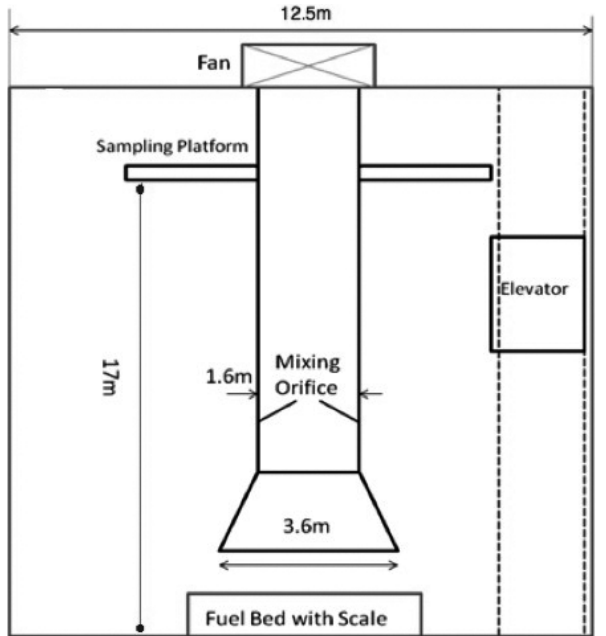
Fig. 1. Schematic drawing of combustion laboratory, USDA Forest Service Fire Sciences Laboratory, Missoula, MT. Detailed charac- teristics of the facility are described in Christian et al. (2004).